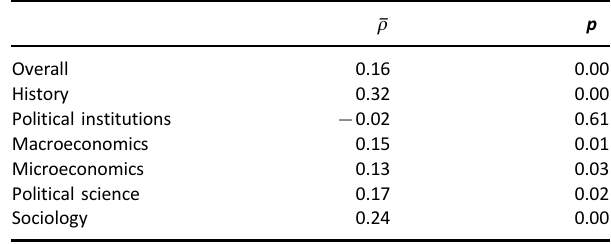
Table 7. Average correlation between SET and interim grades Table 5. Average correlation between SET and gender con-